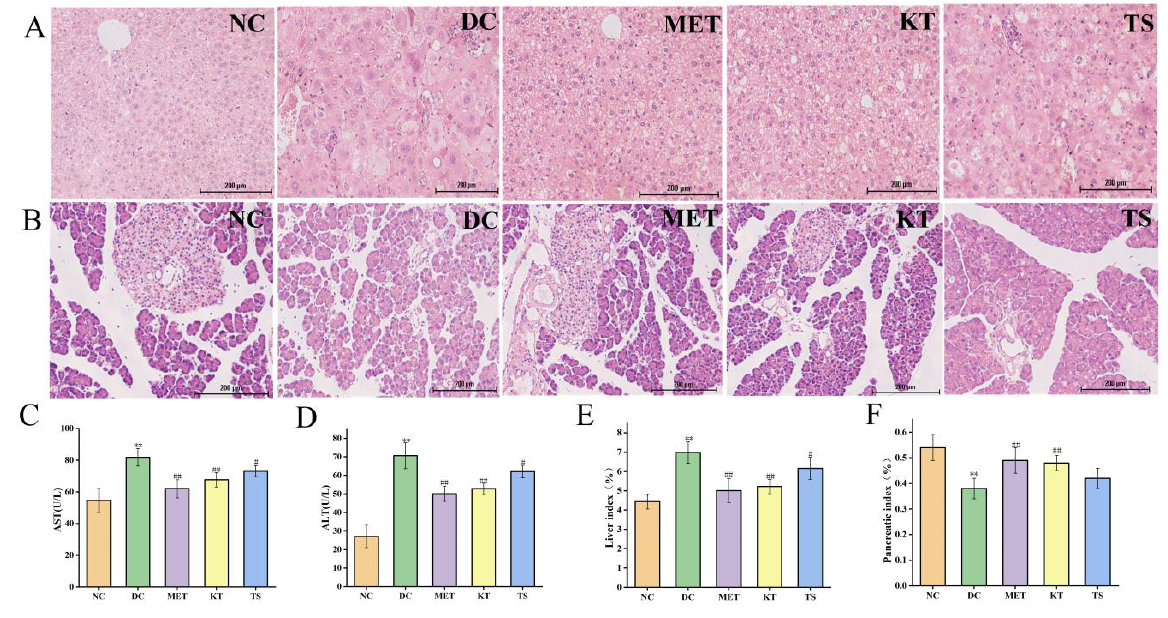
Figure 3. Effects of kombucha on liver and islet tissue injury in T2DM mice. ( A , B ) Histological examination of liver and islet slices with H&E staining (scale bars: 200 µ m); ( C , D ) AST and ALT content in liver; ( E , F ) Liver and pancreatic index. ** p < 0.01 vs. normal; # p < 0.05, ## p < 0.01 vs. model.